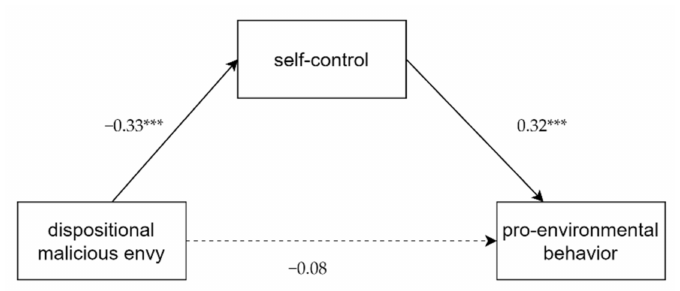
Figure 2. Mediating effect of self-control on DMB and PEB. *** p <